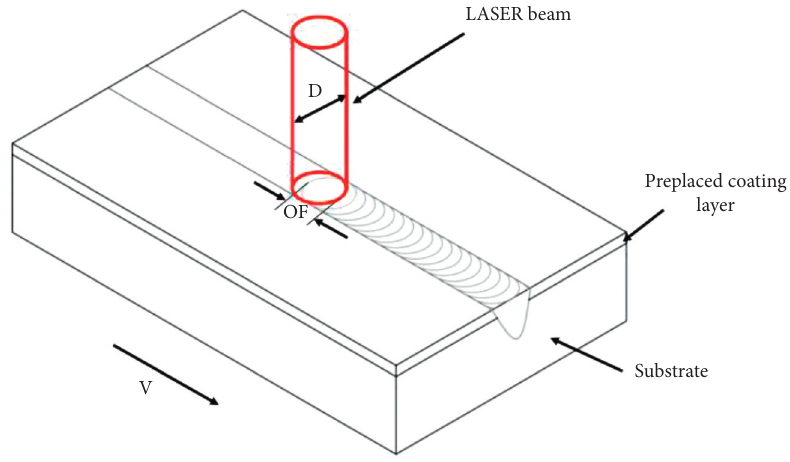
Figure 7: Schematic diagram of laser cladding on